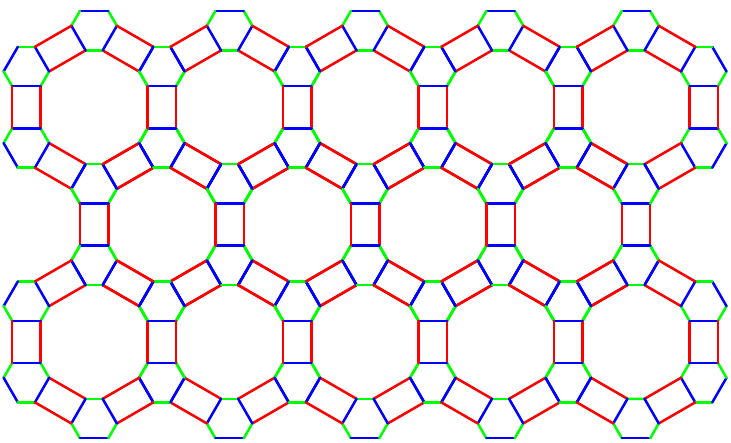
Fig. 39: Tiling with congruent coronas consisting of quadrilateral, hexagon and 12